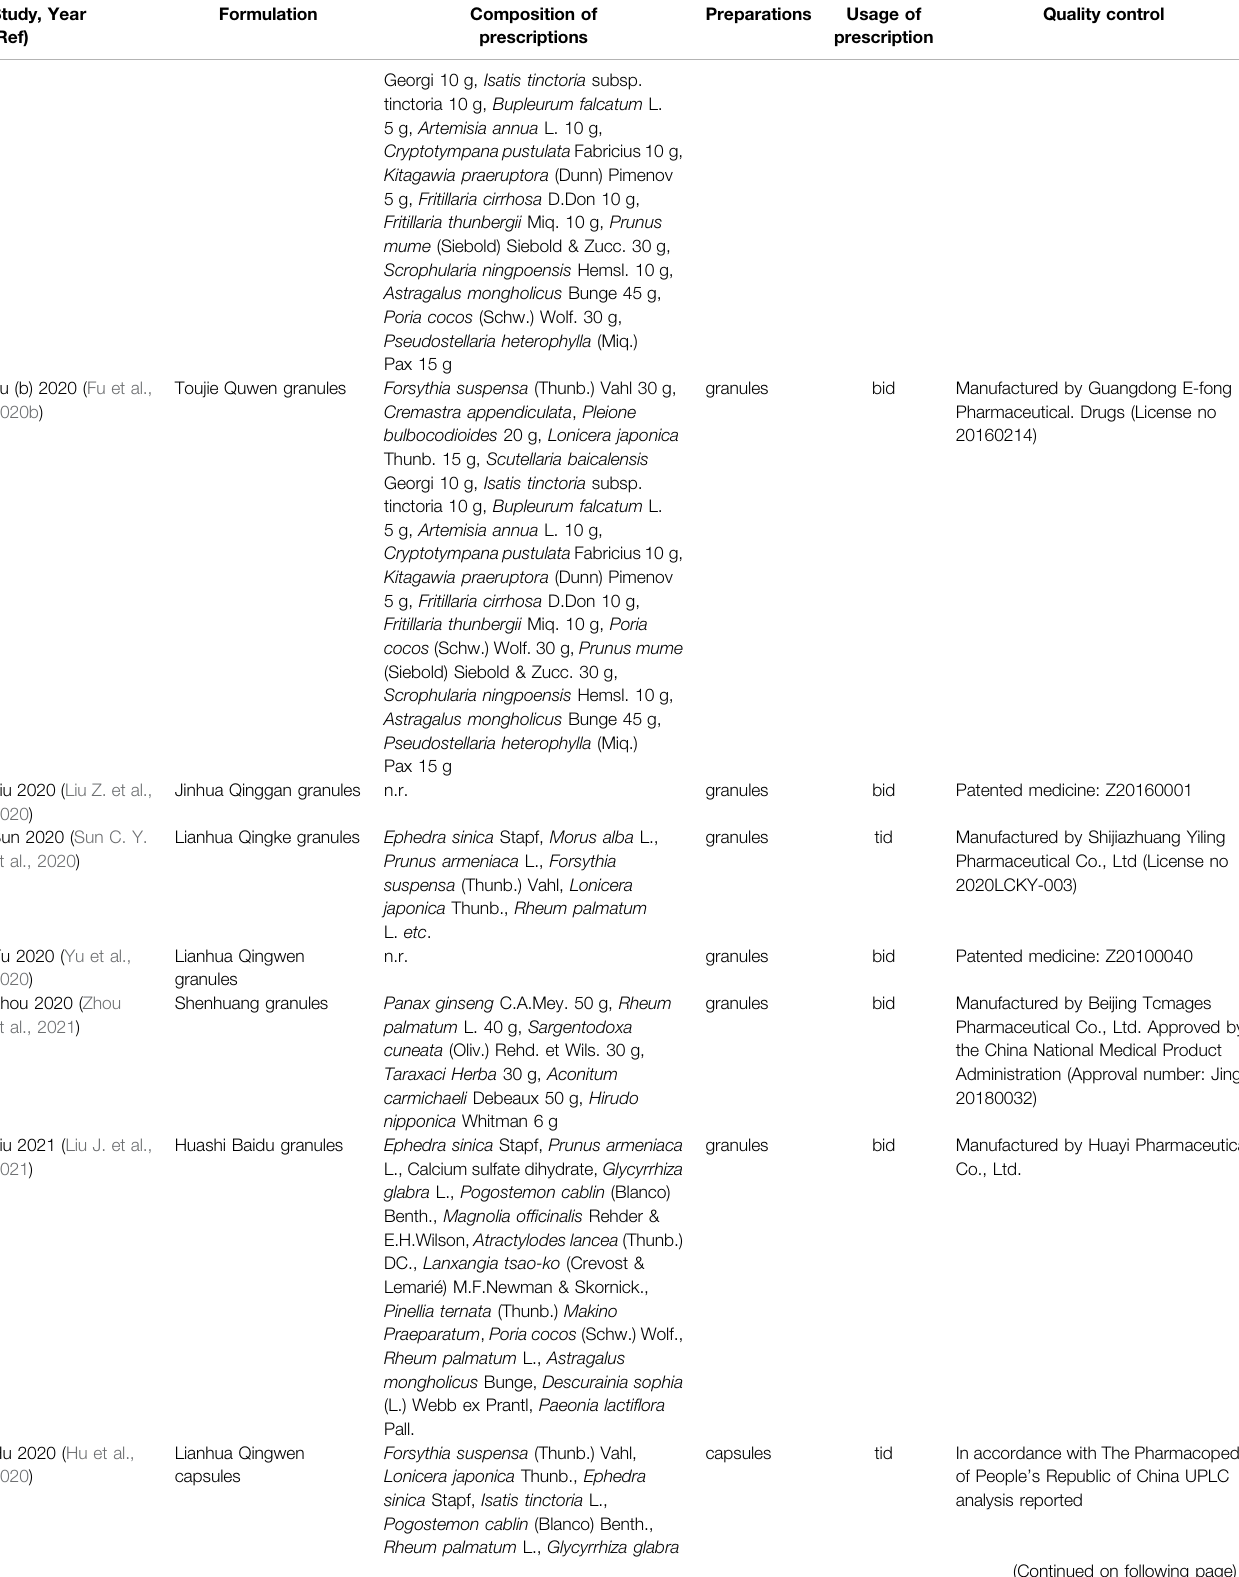
TABLE 2 | ( Continued ) Compositions and usage of herbal medicine for the treatment of